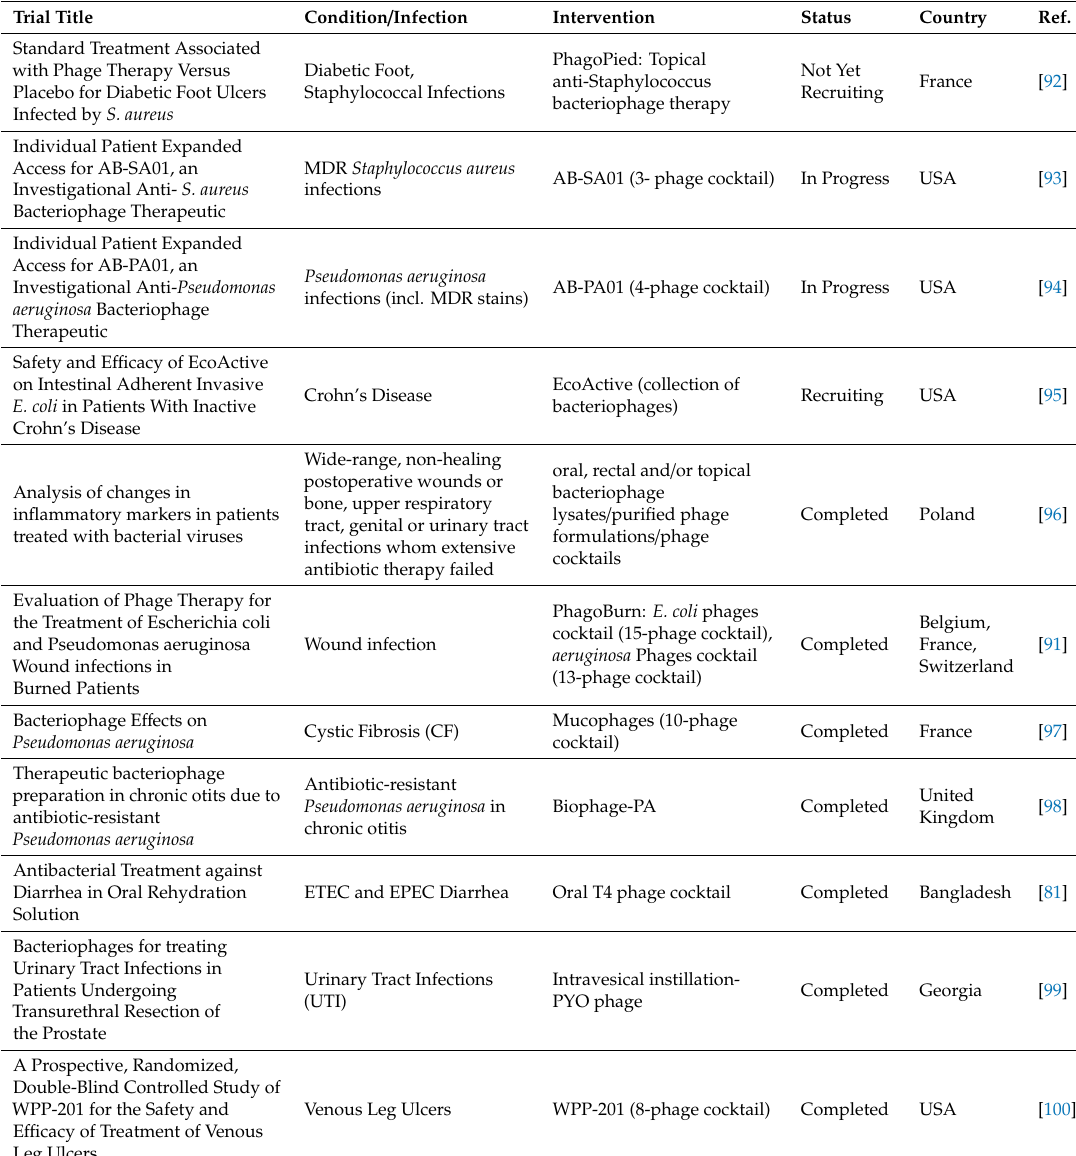
Table 2. Recent Phage Therapy Clinical